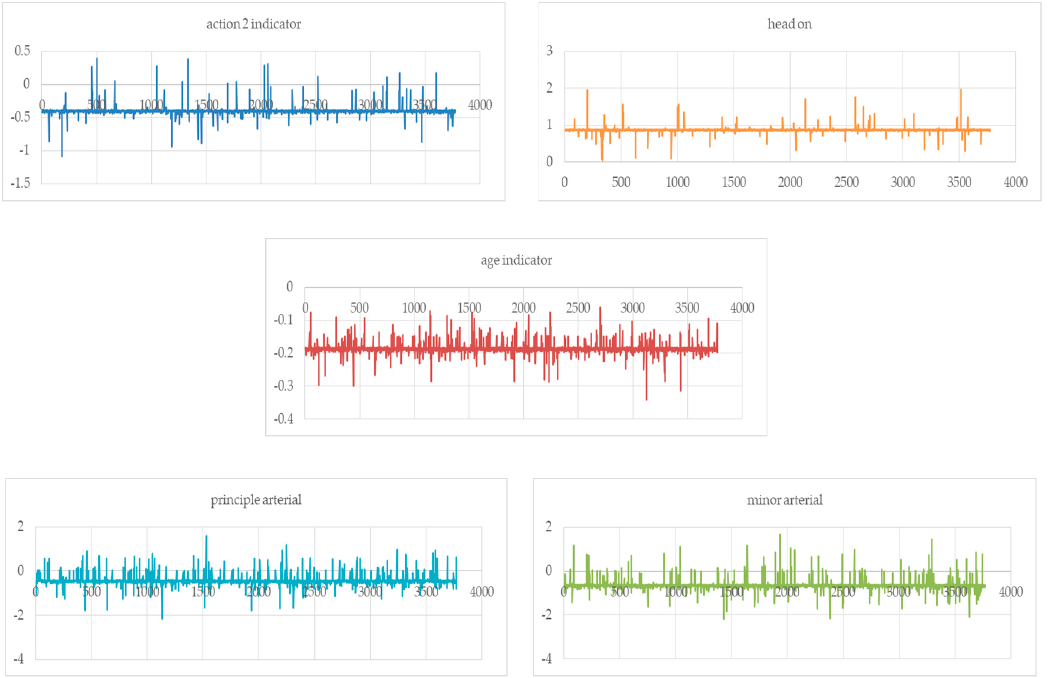
Figure 3. The variation of the random parameters.